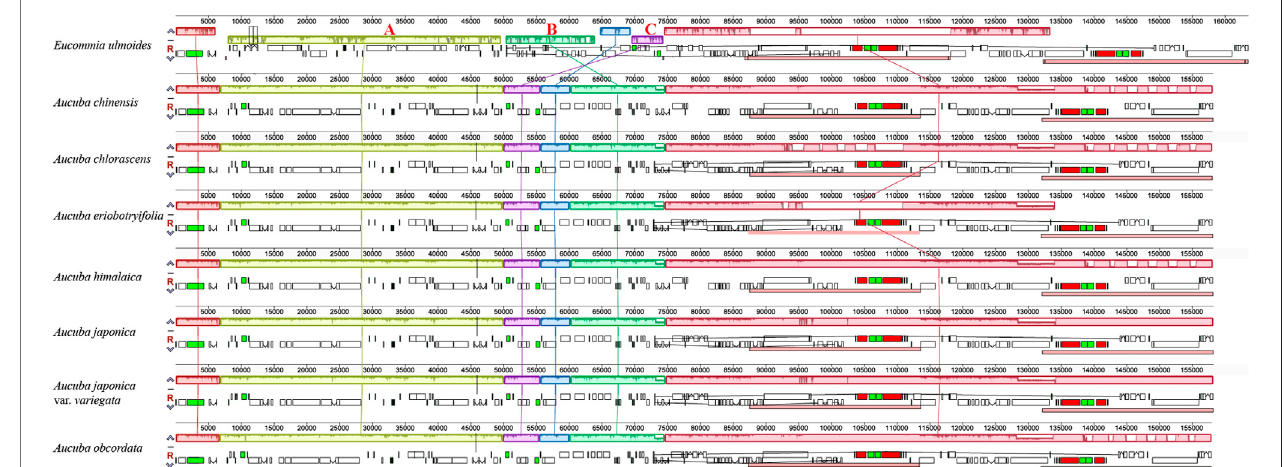
FIGURE 1 | Genomic rearrangements detected in Eucommia ulmoides when compared with plastomes of Aucuba .